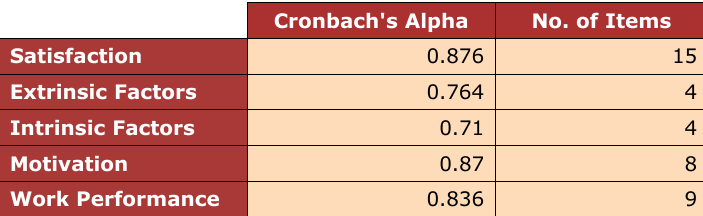
Table 5. Reliability